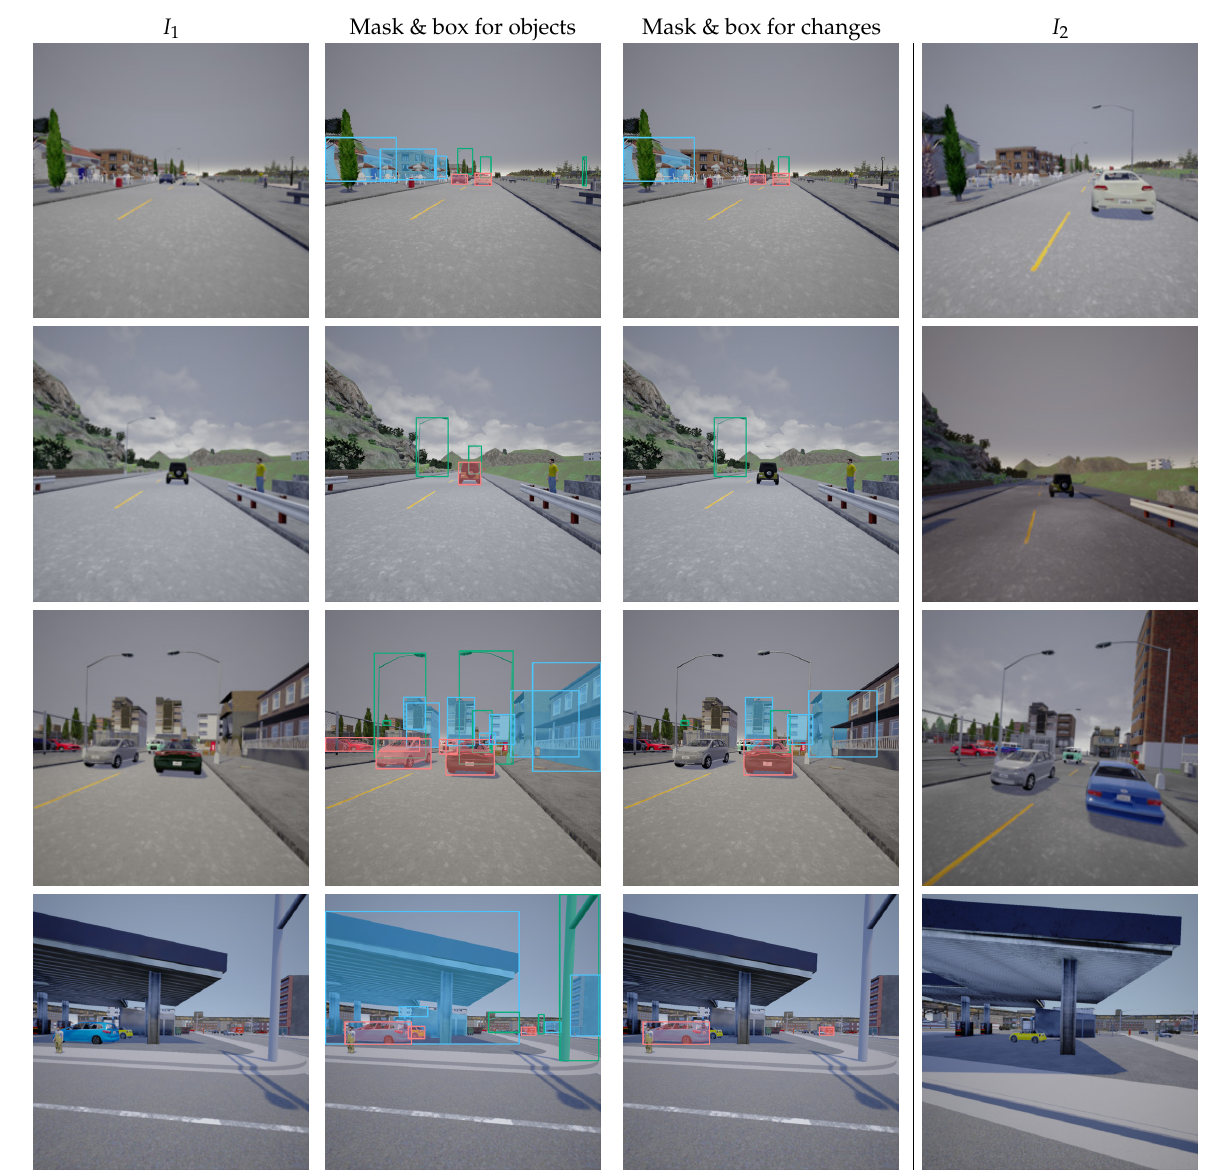
Figure 5. Examples of the instance masks and bounding boxes for the objects/changes. The light blue is buildings, pink is cars, green is poles.